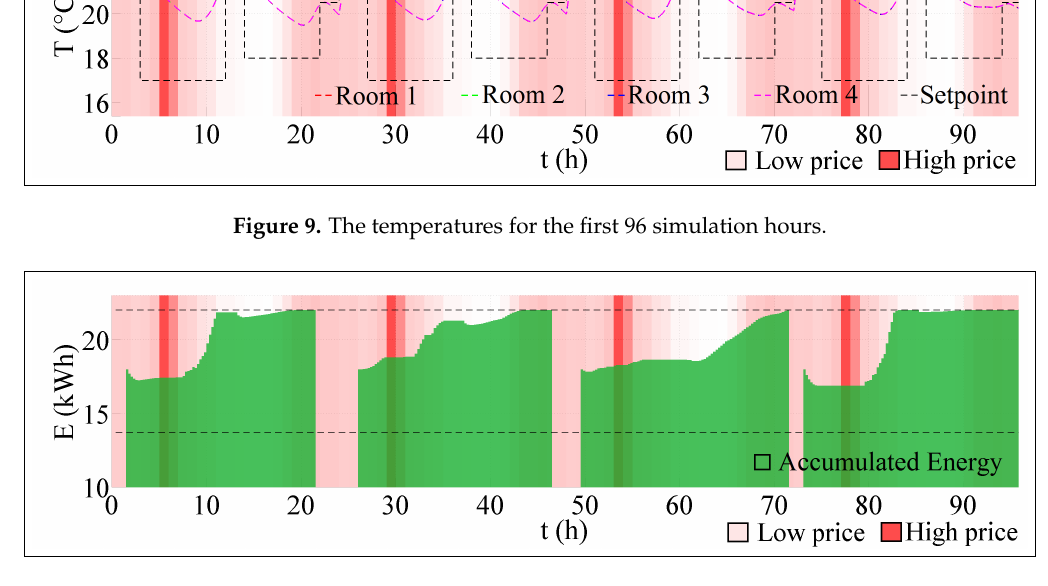
Figure 10. The energy accumulated in the battery for the first 96 simulation hours.